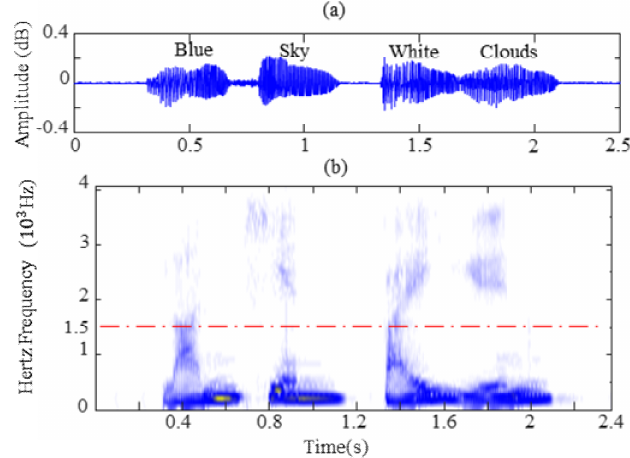
Figure 3. Sound signal: ( a ) original signal waveform; ( b ) STFT.